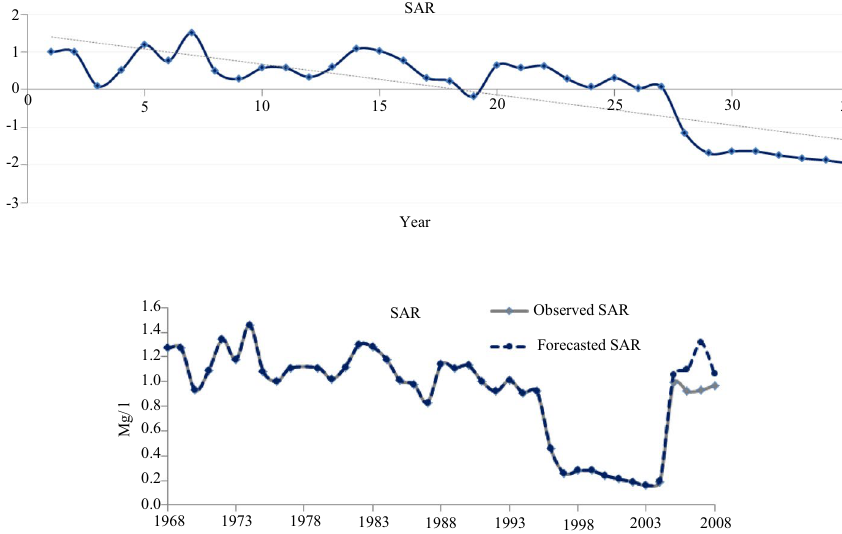
Fig. 10 Unchanging time arrangement of SAR and the foretold values for 5 years